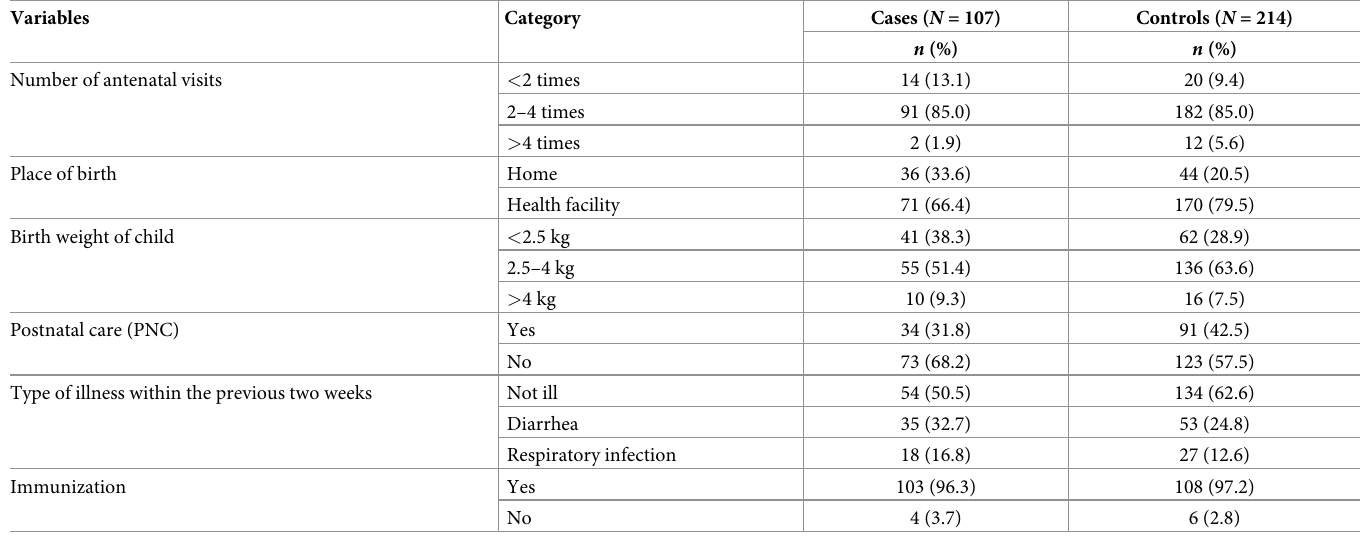
Table 3. Healthcare-related factors among children 6–59 months old in Kemissie City Administration, northeastern Ethiopia, January to April 2017.